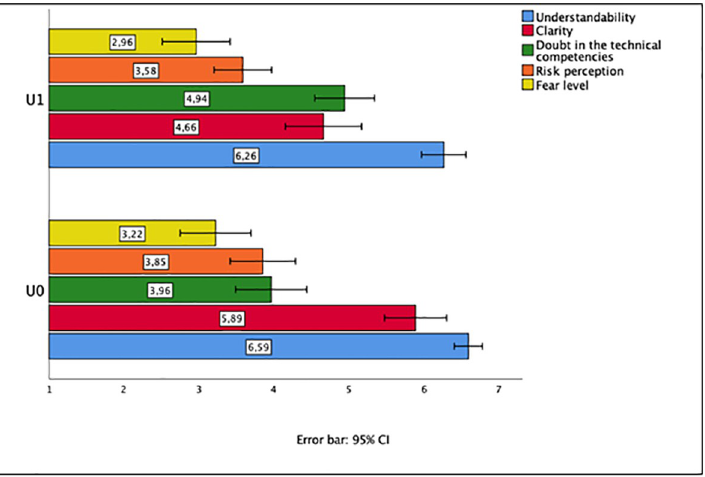
Fig 1. Effects of uncertainty description about regarding hazard identification (factor uncertainty) (R1). Means (with 95% confidence intervals) of the dependent variables (measured on 7-points-Likert scales) for the two levels of factor “uncertainty—U0: no information about uncertainty, U1: information about uncertainty). N.B.: The higher the score on the Likert scale, the higher is the value on the dependent variable.